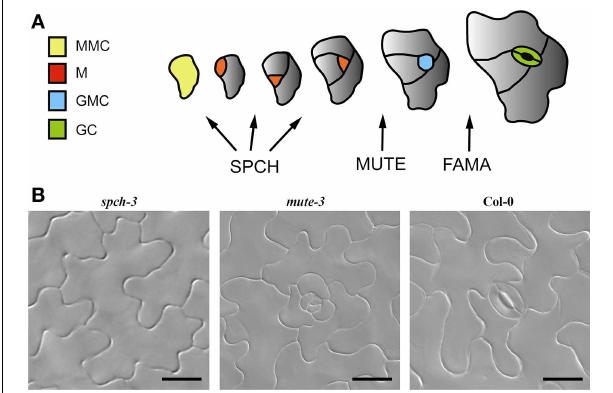
FIGURE 1 | Stomatal development in Arabidopsis. (A) Arabidopsis stomatal development from a protodermal (Meristemoid Mother cell, MMC; yellow) involves sequential cell division and differentiation events that can be grouped into three main stages, regulated by three bHLH transcription factors: SPEECHLESS (SPCH), MUTE, and FAMA. SPCH is required for up to three asymmetric divisions that generate the cells in the stomatal lineage: meristemoids (M, red) and stomatal lineage ground cells (gray) that will eventually differentiate into pavement cells. MUTE is essential for the transition of the youngest meristemoid to a guard mother cell (GMC, blue) and FAMA controls the symmetric division of the GMC, which produces the guard cell pair (GC, green). (B) DIC micrographs of adaxial cotyledons showing the epidermal phenotypes of the genotypes used in this work. Loss-of-function mutations in SPCH ( spch-3) prevent the initiation of stomatal lineages, while mutations in MUTE ( mute-3 ) allow lineages to initiate and develop, but they arrest prior to stomata differentiation. Col-0 is a wild-type accession. Bar, 20 µ